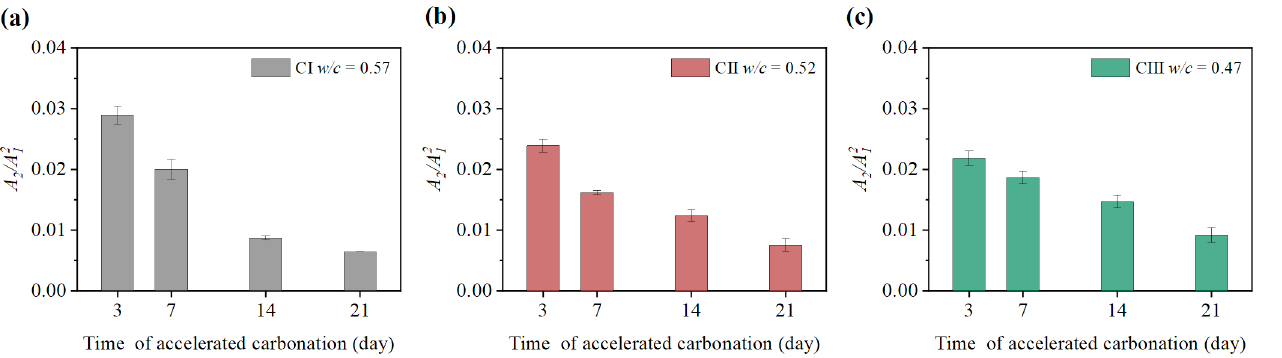
Figure 13. Variation of nonlinear parameter A 2 / A 2 ( b ) nonlinear parameter A 2 / A 2